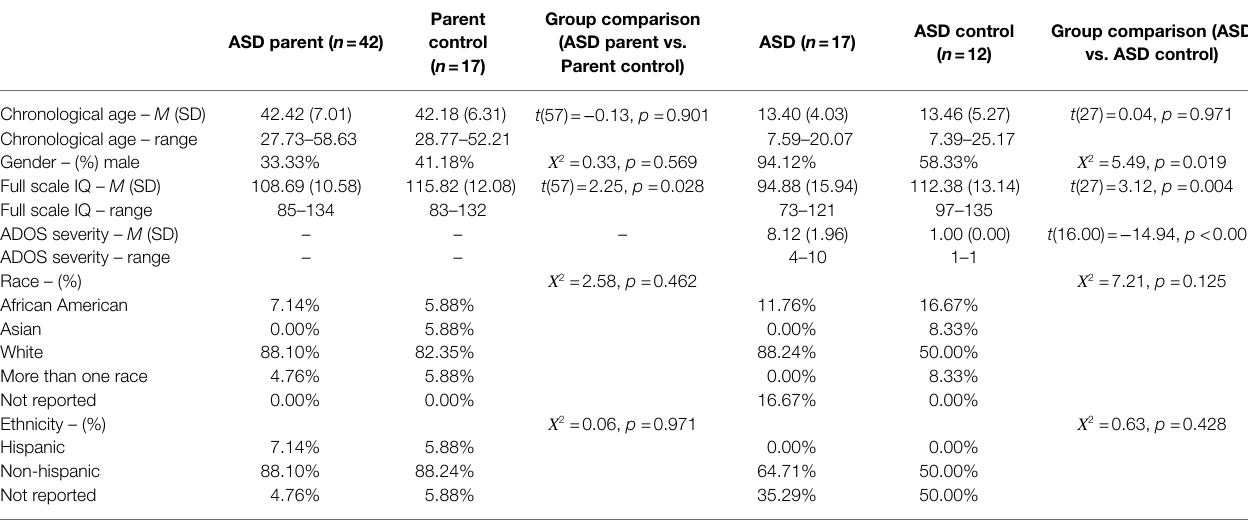
TABLE 1 | Participant